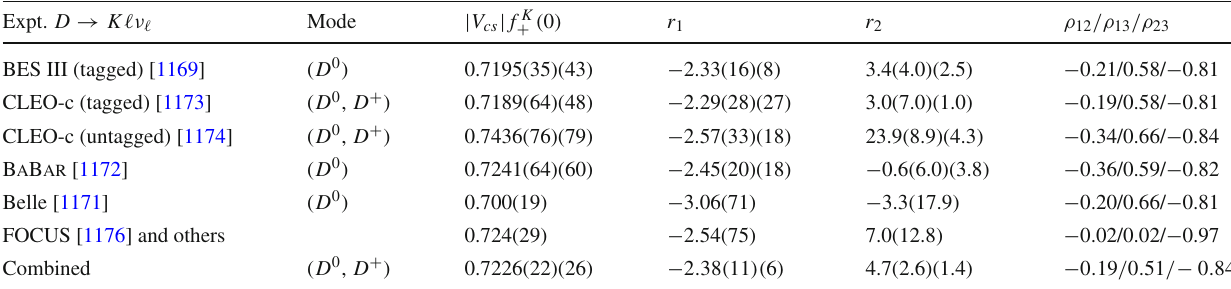
e + ν e decay channel from BES III [1170] is Table 275 Results of the fits to D → K (cid:12)ν (cid:12) measurements from sev- result for the D + → K 0 L eral experiments, using the z -expansion. External inputs have been included in the combined results as a constraint on the normalization, | V | f K ( 0 ) . The entry others refers to total decay rates measured by updated to PDG [327]. The correlation coefficients listed in the last + cs column refer to ρ 12 ≡ ρ | , ρ 13 ≡ ρ | , and ρ 23 ≡ V cs | f K + ( 0 ), r 1 V cs | f K + ( 0 ), r 2 ρ ⊕ systematic). The r 1 , r 2 and are for the total uncertainties (statistical